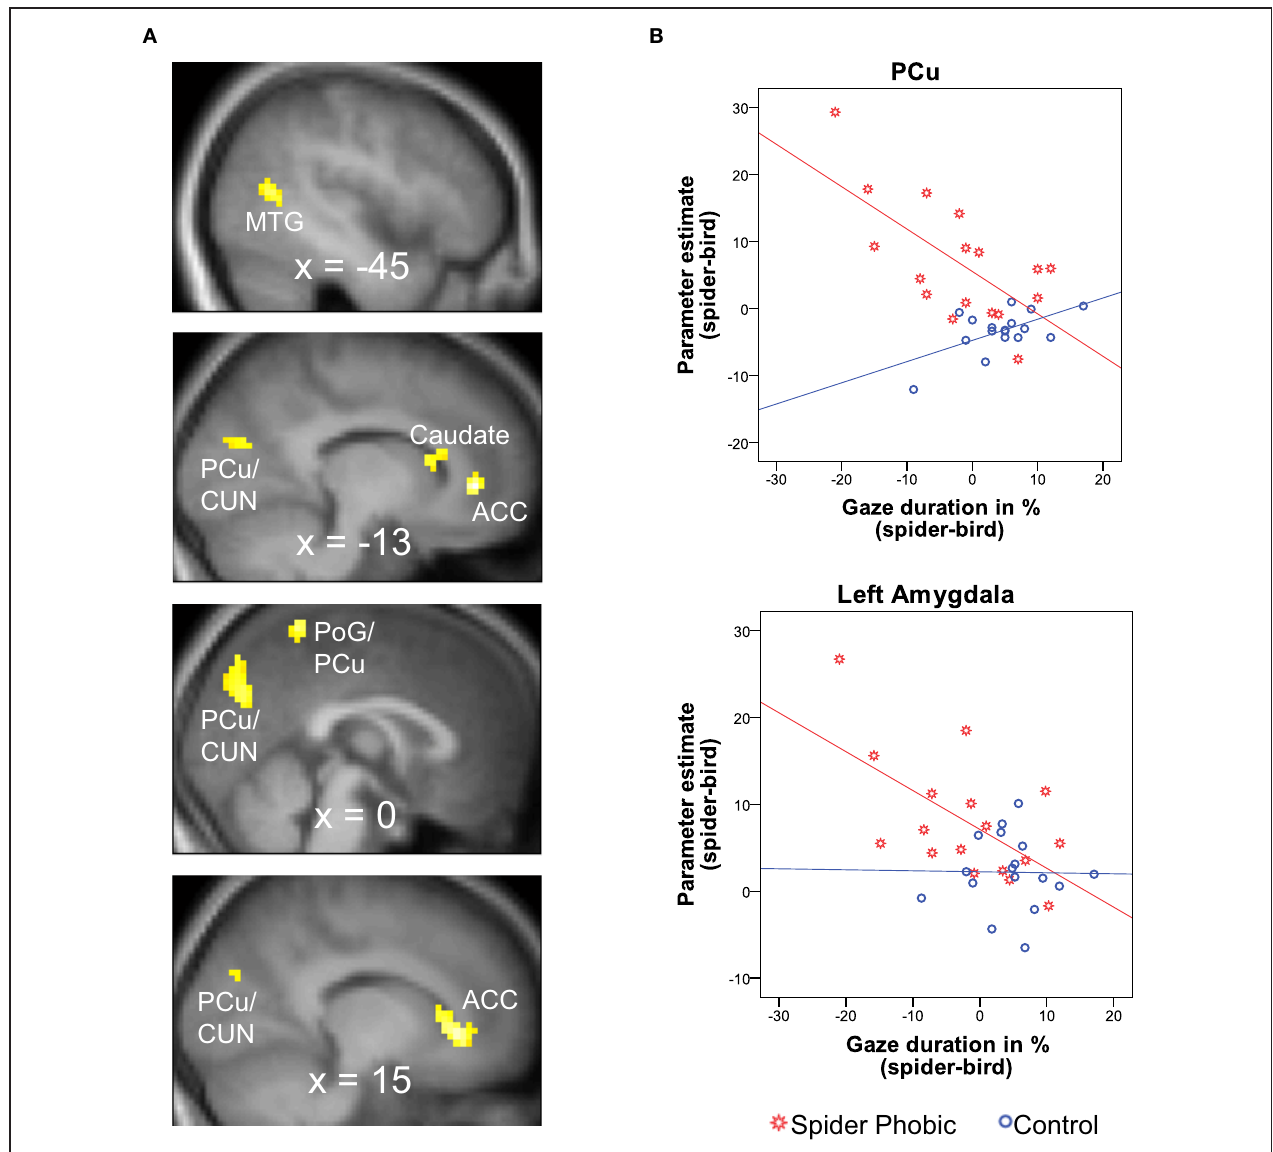
effects for the precuneus (largest cluster in whole-brain analysis) and the left amygdala (ROI analysis). ACC, anterior cingulate gyrus; CUN, cuneus; MTG, middle temporal gyrus; PCu, precuneus; PoG, postcentral gyrus; ROI, region of